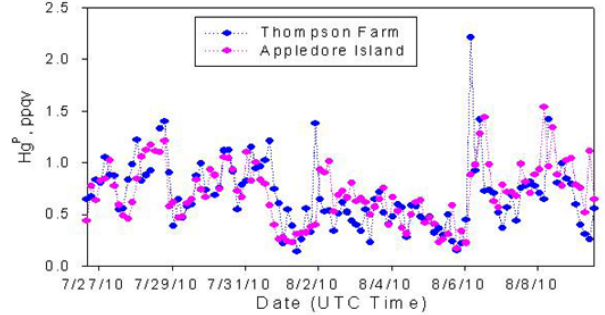
Fig. 8. Bulk filter data from summer 2010 at Thompson Farm (blue) and Appledore Island (pink) showing both sites track each other nicely as a result of similar sources of air masses as shown in Fig. 7. There are some discrepancies between the two locations; Thompson Farm has two outlying points which may be attributed to local in- terferences that affected Thompson Farm but not Appledore Island, such as fires and fog.